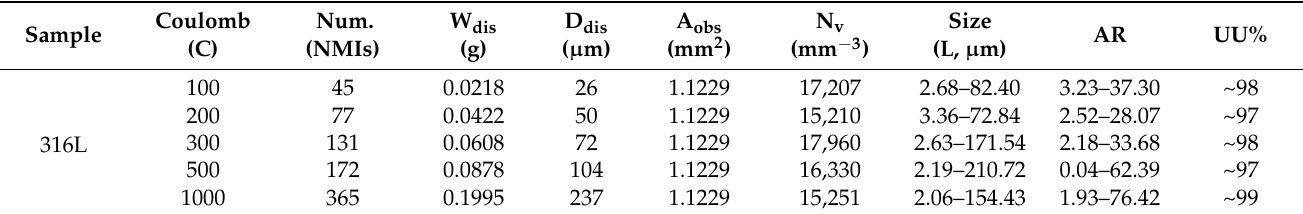
Table 13. The characteristics of elongated sulfides in the steel of 316L after different charges ap- plied using Method 2.